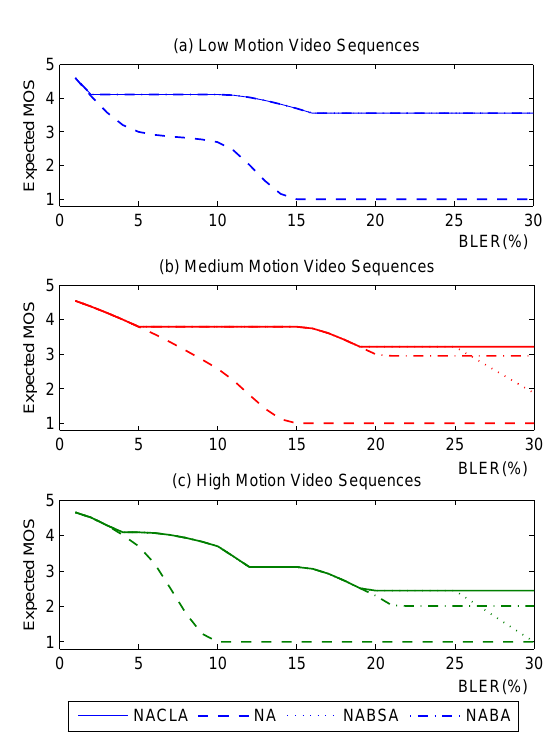
Figure 5. Quality achieved by the different adaptation approaches for (a) low motion, (b) medium motion, (c) high motion